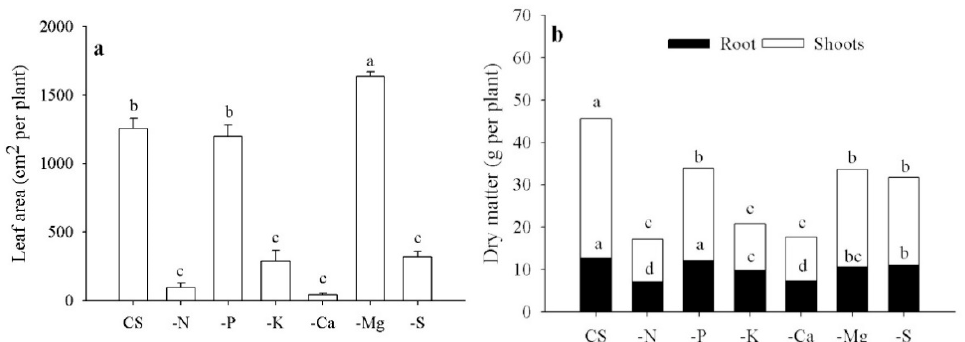
Figure 3. Leaf area ( a ) and dry matter ( b ) of broccoli ( Brassica oleracea var. italica L.) plants cultivated with a complete nutrient solution (CS) and under macronutrient omission (-N, -P, -K, -Ca, -Mg and -S). Mean values (column) followed by di ff erent letters indicate a statistically significant di ff erence by the Tukey test ( p ≤ 0.05).